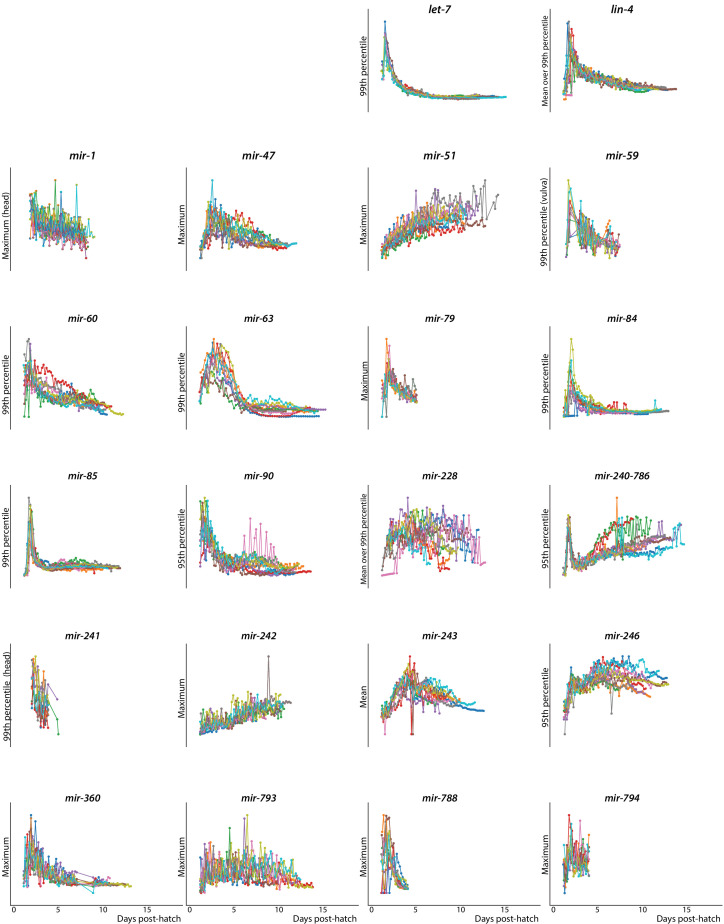
Timecourse of expression for 10 randomly selected individuals from all PmiRNA::GFP reporters.